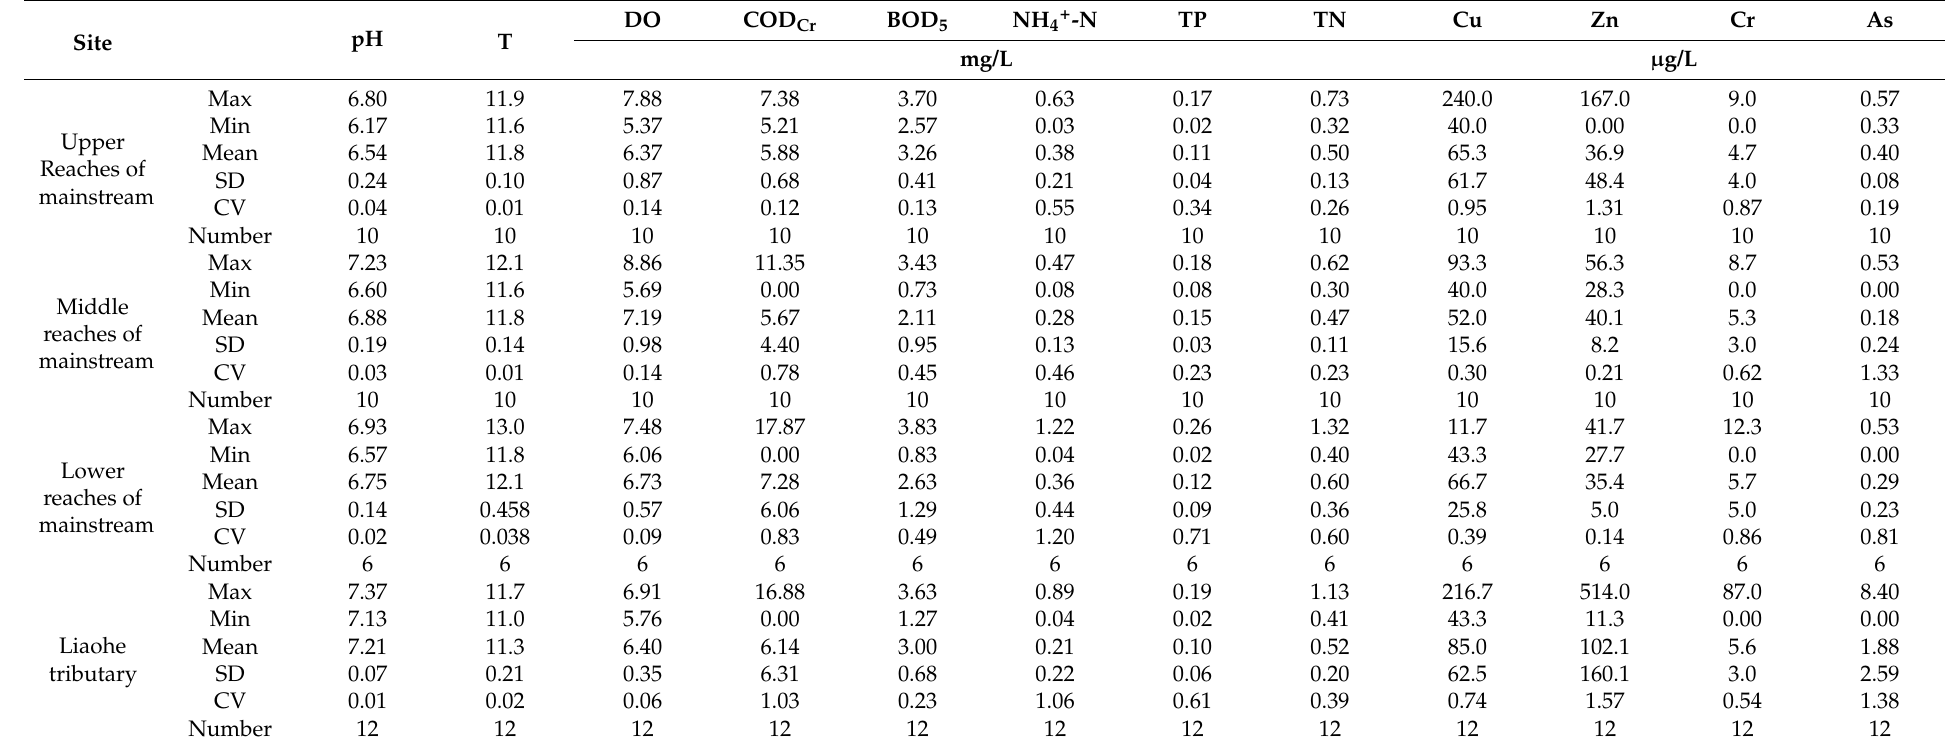
Table 1. Characteristics of the water chemistry and heavy metal parameters of the Xiujiang